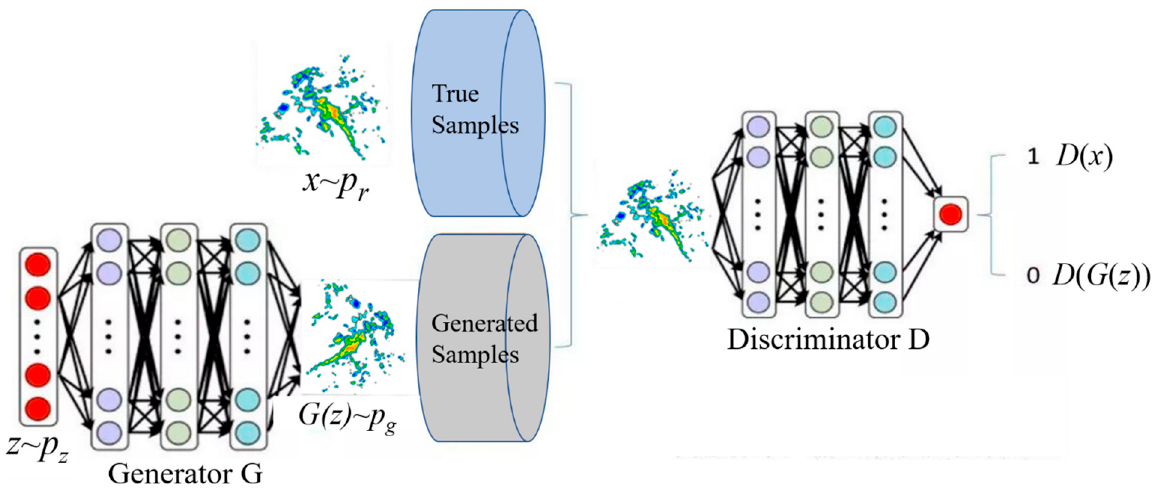
Figure 1. The basic structure of the Generative Adversarial Network.